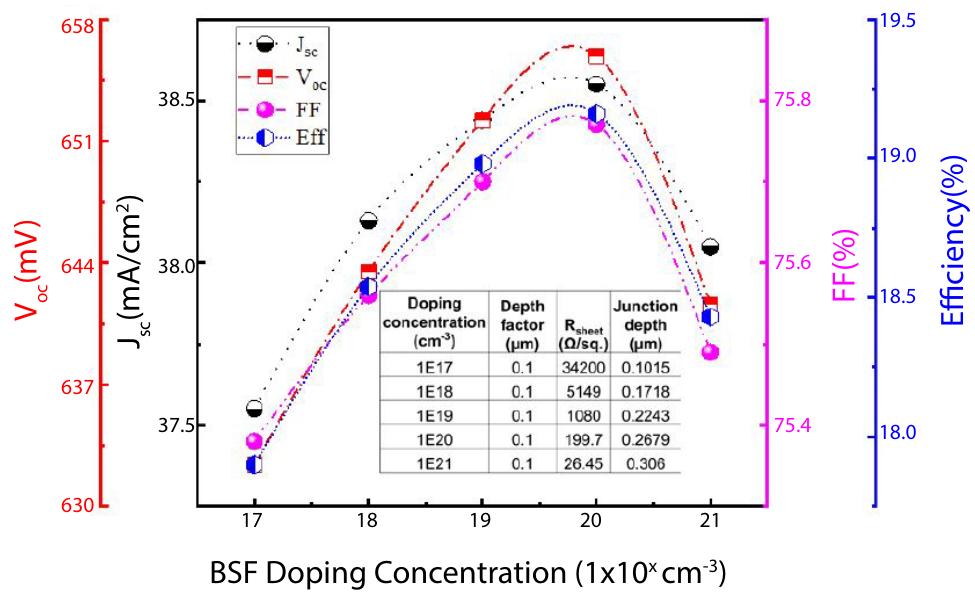
Figure 7. I–V characteristics with respect to BSF doping level. Inset shows the variation in the I–V parameters as function of BSF doping level.